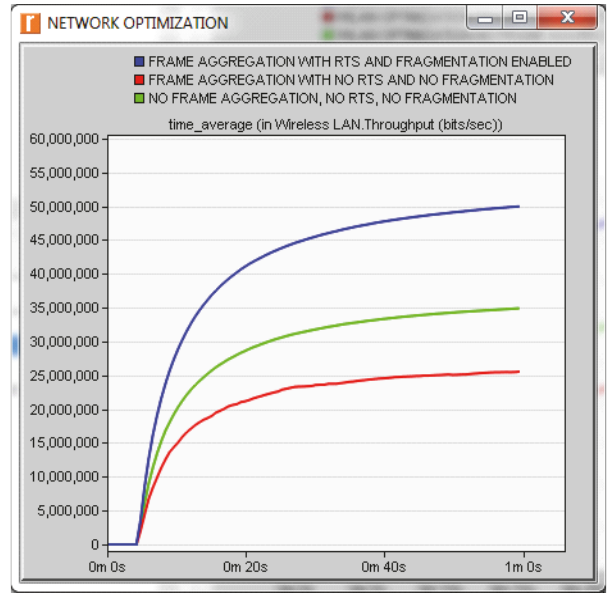
Figure 38: WLAN throughput with and without frame aggregation.